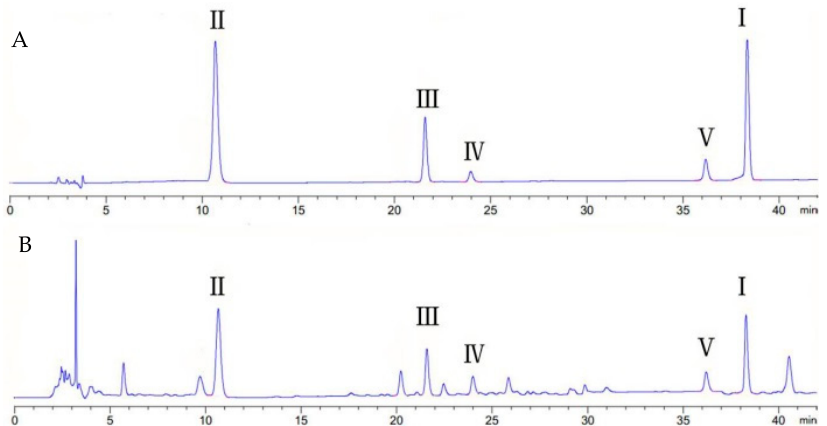
Figure 5. Chromatograms of five active components in the root of G. uralensis : ( A ) reference standard; ( B ) sample. I , glycyrrhizin; ΙΙ , liquiritin; ΙΙΙ , isoliquiritin; Ι V , liquiritigenin; V , isoliquiritigenin.